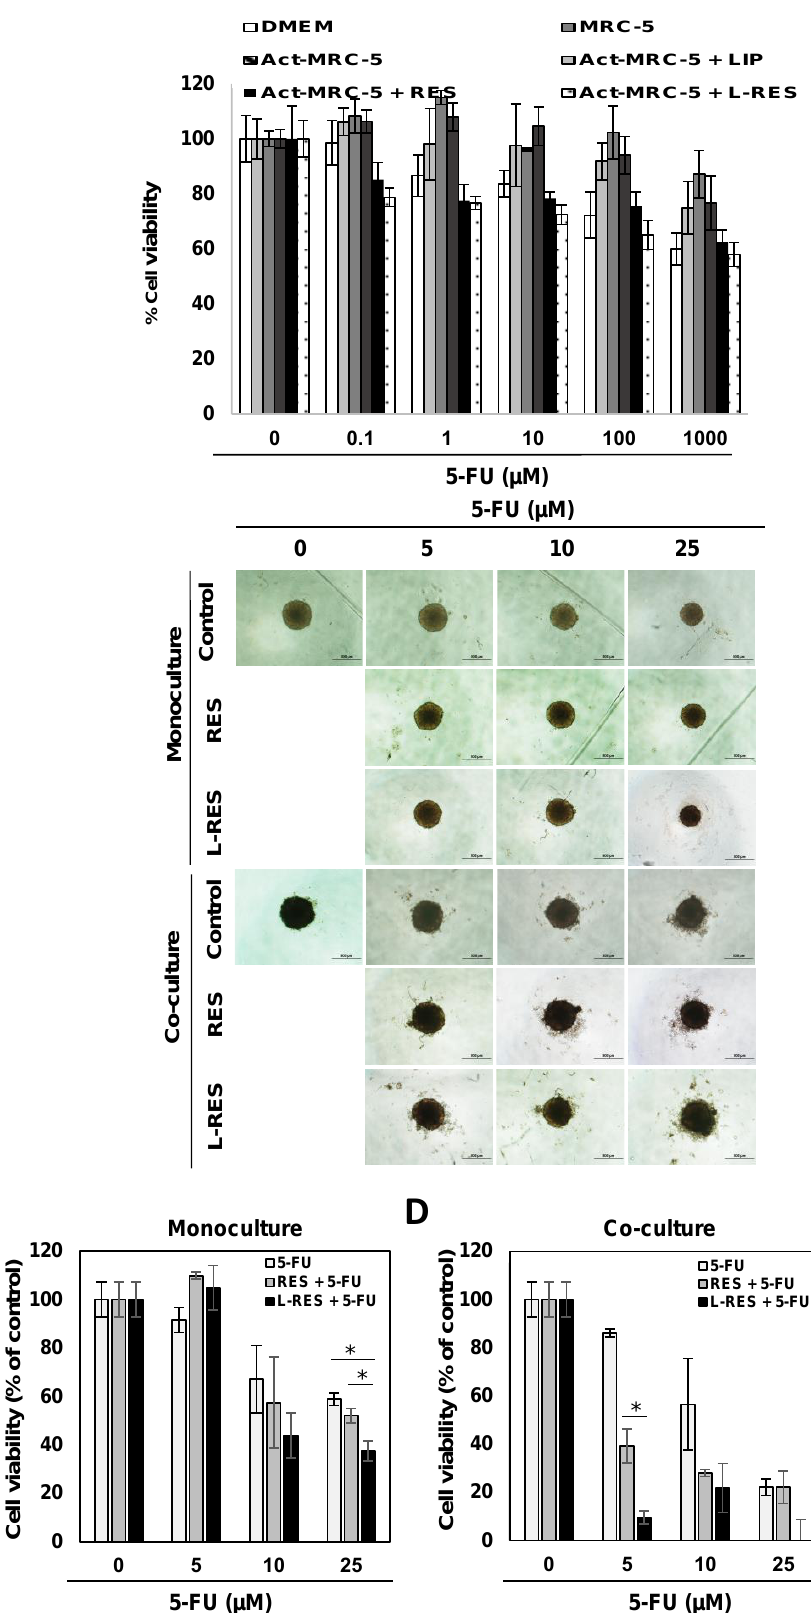
Figure 7. L-RES treatment sensitizes CRC cells to chemotherapeutic drugs when co-cultured with activated fibroblasts. ( A ) HT-29 cell monolayers were exposed to conditioned